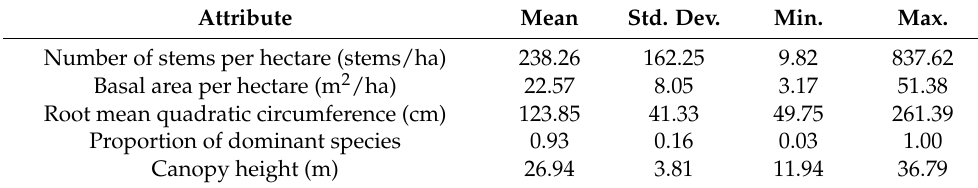
Table 1. Forest management inventory (FMI) forest attributes ( n = 178).